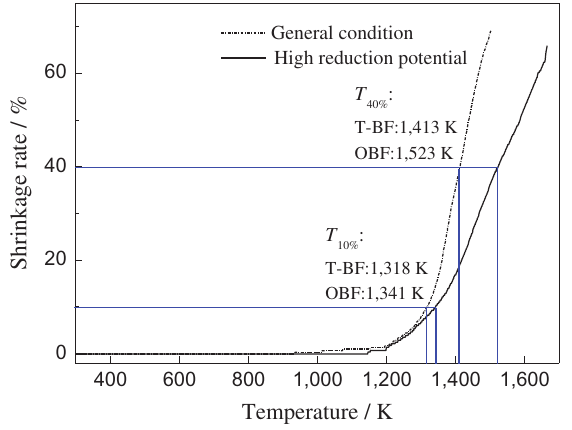
Figure 12: The shrinkage rate – temperature curve of the mixture in general condition and high reduction potential condition.